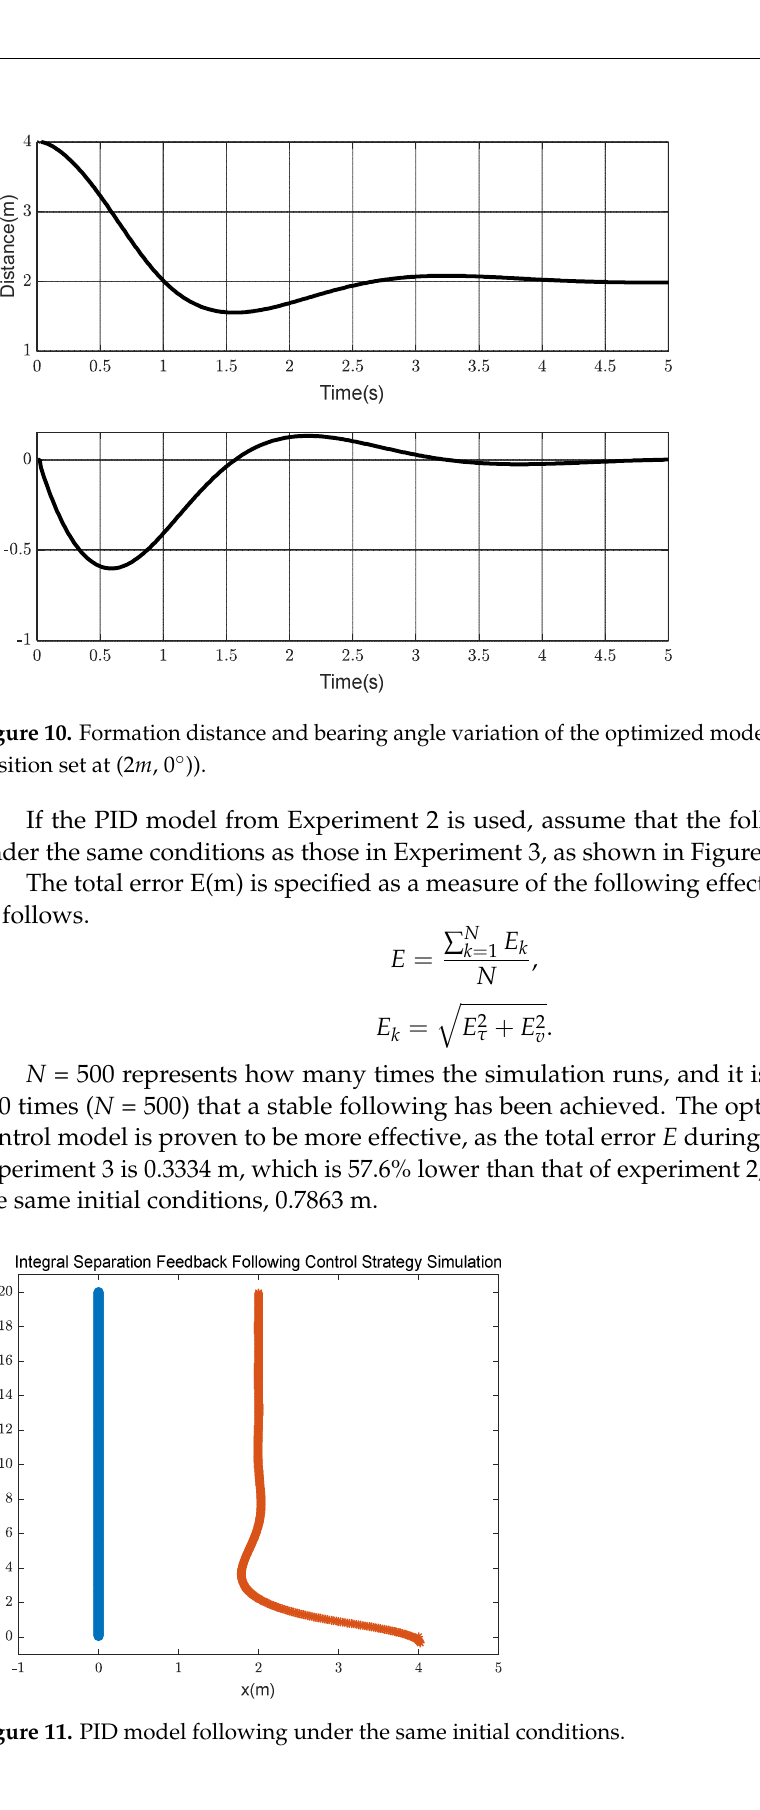
Figure 11. PID model following under the same initial